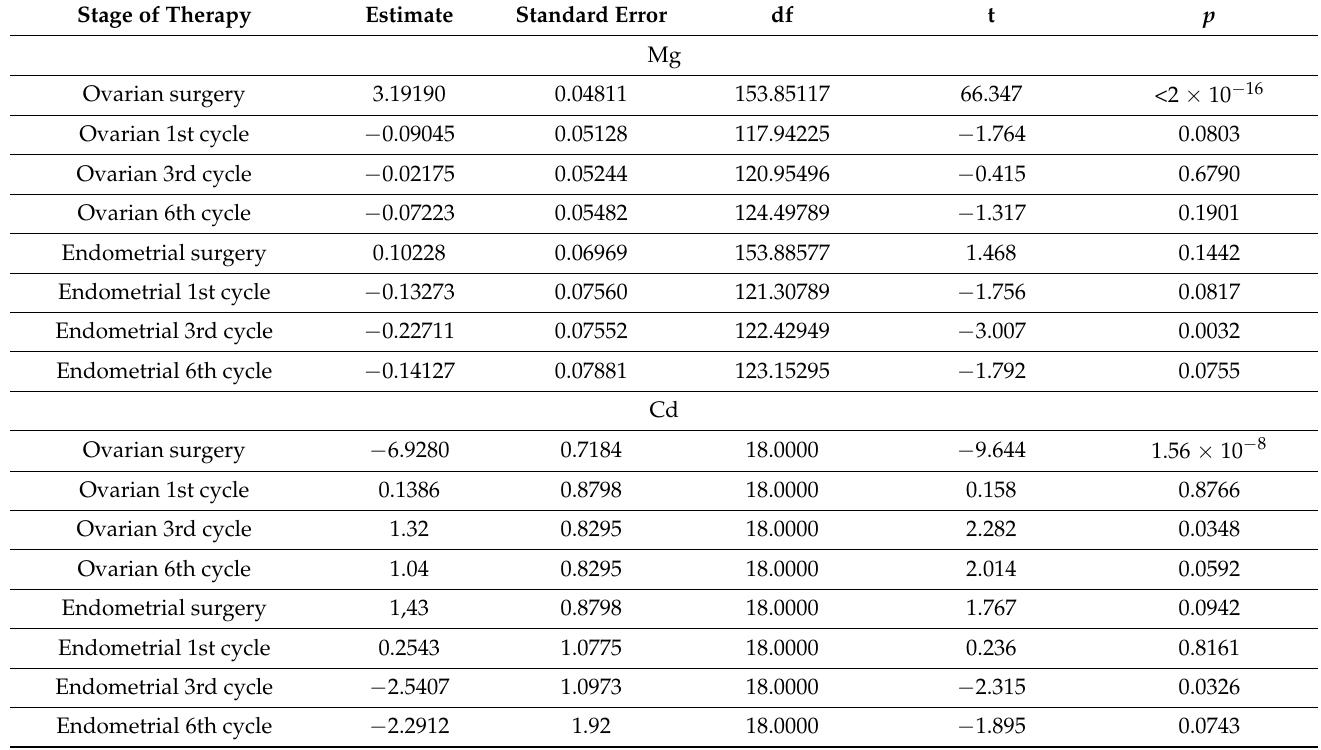
Table 5. The correlations between the concentrations of the tested elements and the stage of therapy.